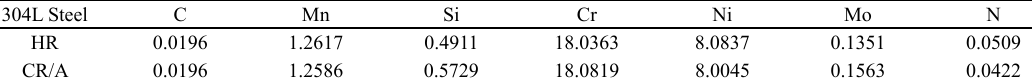
Table 1. Chemical composition of 304L steel (weight %).